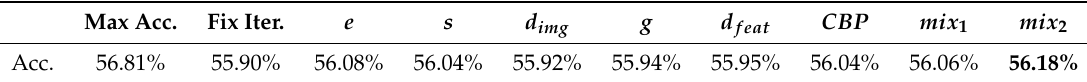
Table 3. Average accuracy (Acc.) on the STL test set obtained stopping the training with different strategies (the experiments were repeated 20 times and the accuracies were averaged). Max Acc.